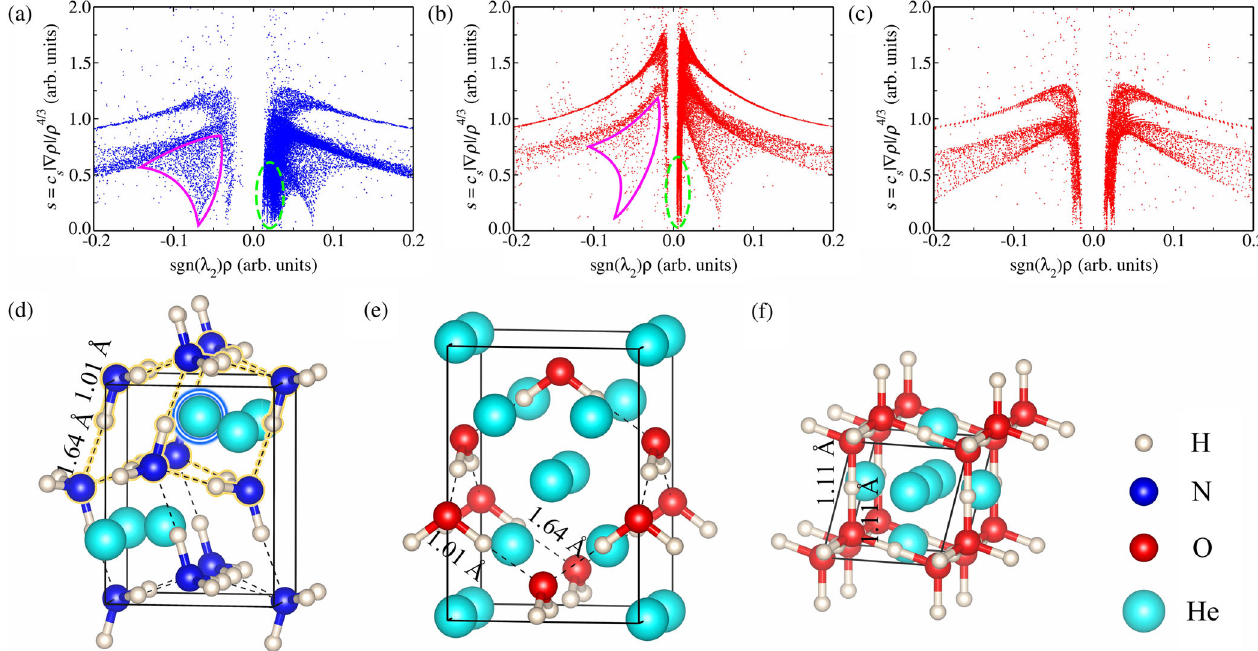
FIG. 5. RDG analysis and corresponding structural environment of helium atoms in the HeNH 3 compound, compared with that in the helium water system. (a) – (c) Plots of RDG versus the electron density multiplied by the sign of the second Hessian eigenvalue for Pnma ¯3 m HeNH 3 at 100 GPa, I 4 1 md He 2 H 2 O at 10 GPa, and Fd He 2 H 2 O at 100 GPa. The solid magenta (dashed green) line region represents the hydrogen bond (vdW interactions) in the crystalline. (d) – (f) Crystal structure of the abovementioned three structures. The covalent bond length and hydrogen bond length are marked nearby. In the HeNH 3 , blue highlighted helium atoms are enclosed in a light yellow highlighted distorted cubic sublattice, consisting of N ─ H covalent bonds and H ─ N hydrogen